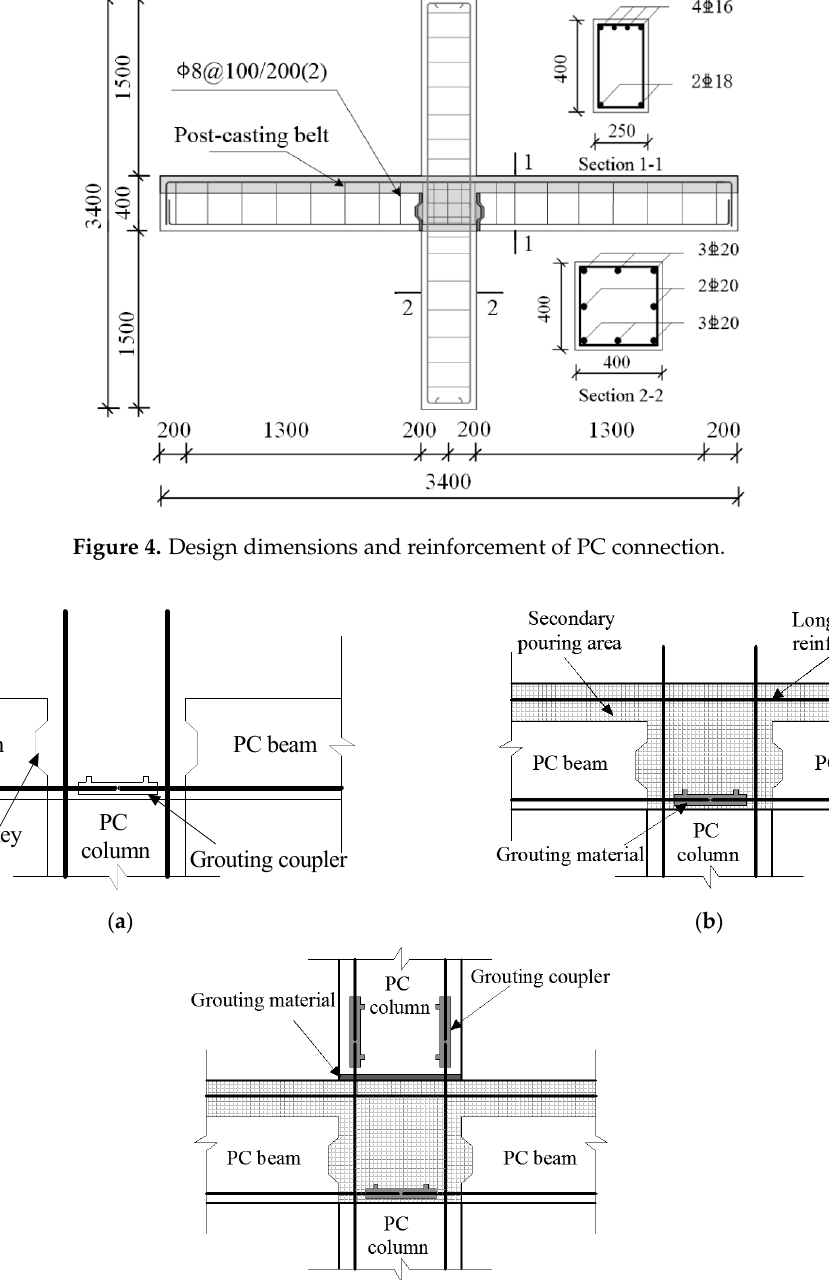
Figure 3. Post-tensioning tendon construction: ( a ) embedding corrugated duct; ( b ) prestress wire tensioning; ( c ) prestress wire anchorage.